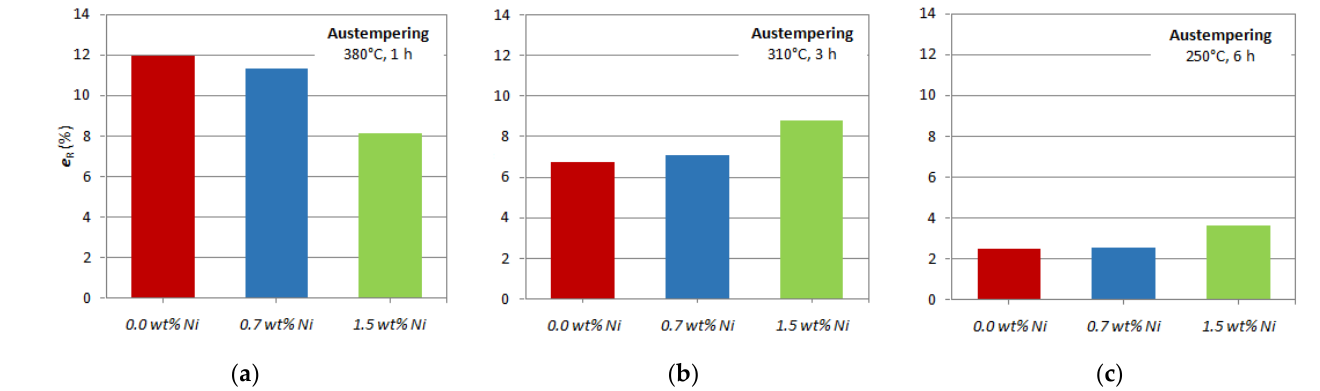
Figure 16. Mean elongations to rupture ( e R ) from 25 mm Y-block ADIs for different Ni contents and different austempering conditions: ( a ) 380 °C for 1h; ( b ) 310 °C for 3h; ( c ) 250 °C for 6h.